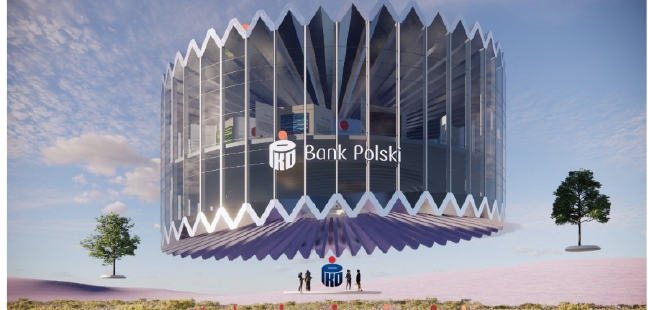
Figure 34: Bank Polski in the Metaverse JP Morgan was one of the first banks in the world to launch its metaverse headquarters in the Decentraland [53] [figure 35] :